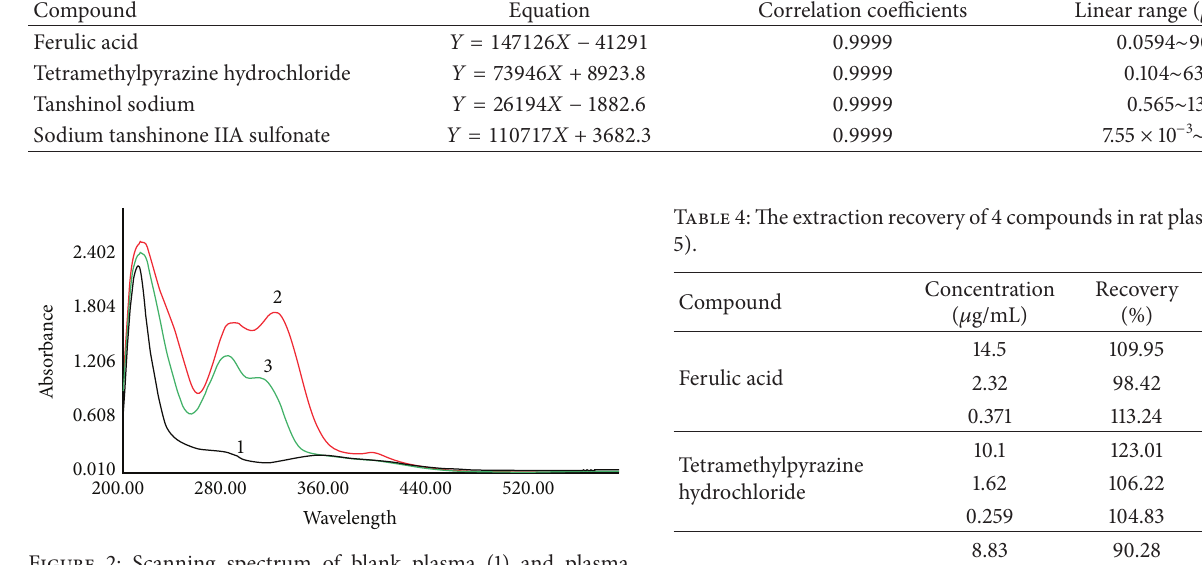
Figure 2: Scanning spectrum of blank plasma (1) and plasma sample obtained at 5 and 30min with 4 components and potential metabolites after i.v. administration (2 and 3).